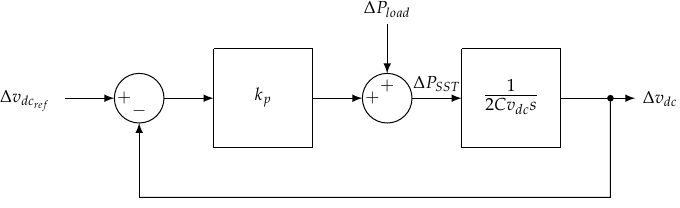
Figure 4. DC-Link power balance